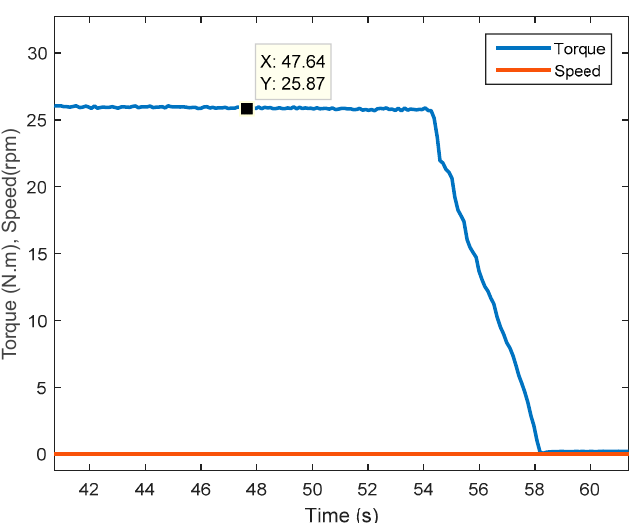
Figure 11. Experimental measurement on test-bench.